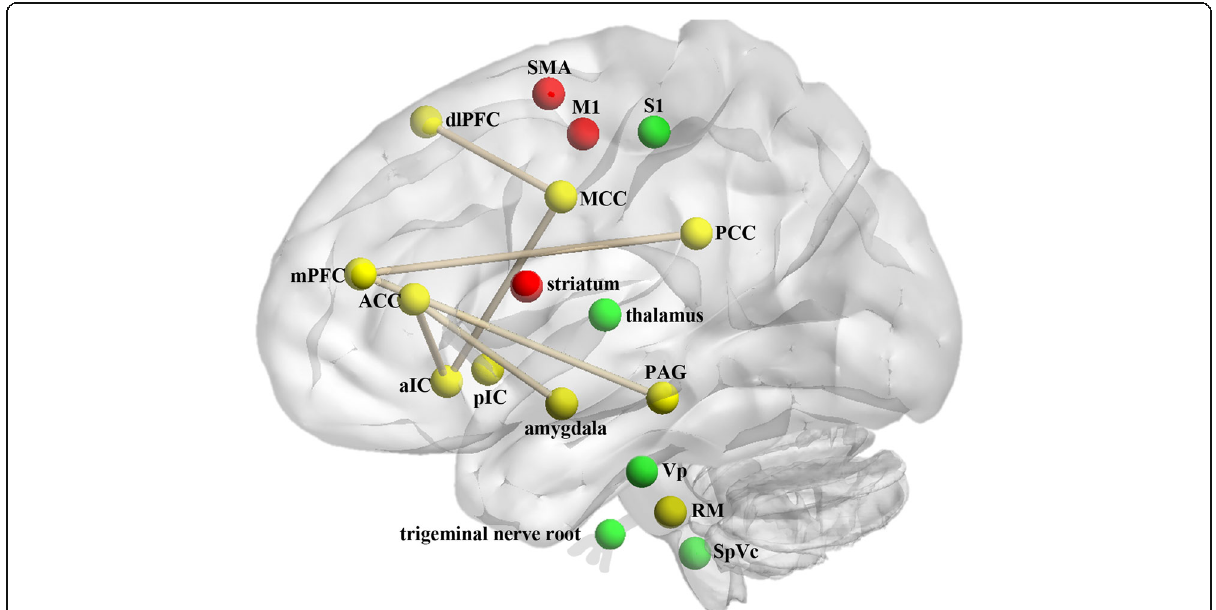
Fig. 2 Schematic representation of main brain regions with altered structure and function involved in TMD related-pain. Green balls represent the areas in the classic trigemino-thalamo-cortical system. Red balls are in the motor system. Yellow balls are the brain cortical regions implicated in pain perception and pain modulation. Brain regions with altered functional connectivity in TMD are connected with lines in khaki. Abbreviations: SMA, supplementary motor areas; dlPFC, dorsolateral prefrontal cortex; M1, primary motor cortex; S1, primary somatosensory cortex; MCC, mid- cingulate cortex; mPFC, medial prefrontal cortex; ACC, anterior cingulate cortex; PCC, posterior cingulate cortex; aIC, anterior insular cortex; pIC, posterior insular cortex; PAG, periaqueductal gray; Vp, trigeminal principal sensory nucleus; RM, raphe magnus; SpVc, spinal tract subnucleus